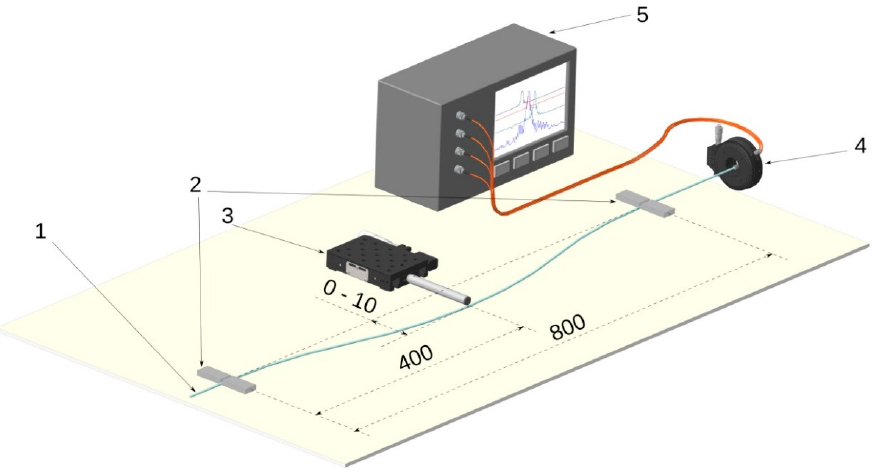
Figure 3. Experimental setup: 1—four core fiber, 2—side supports, 3—micrometer screw, 4—rotation mount, 5—interrogator.